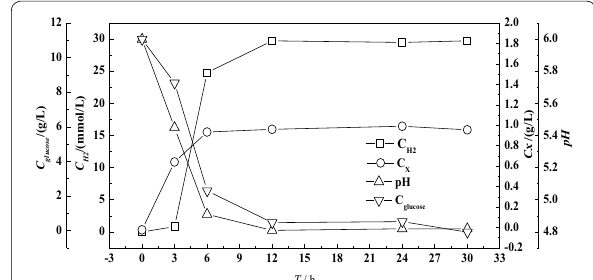
Fig. 4 The properties of biohydrogen production through glucose anaerobic fermentation by EB-06 in batch culture